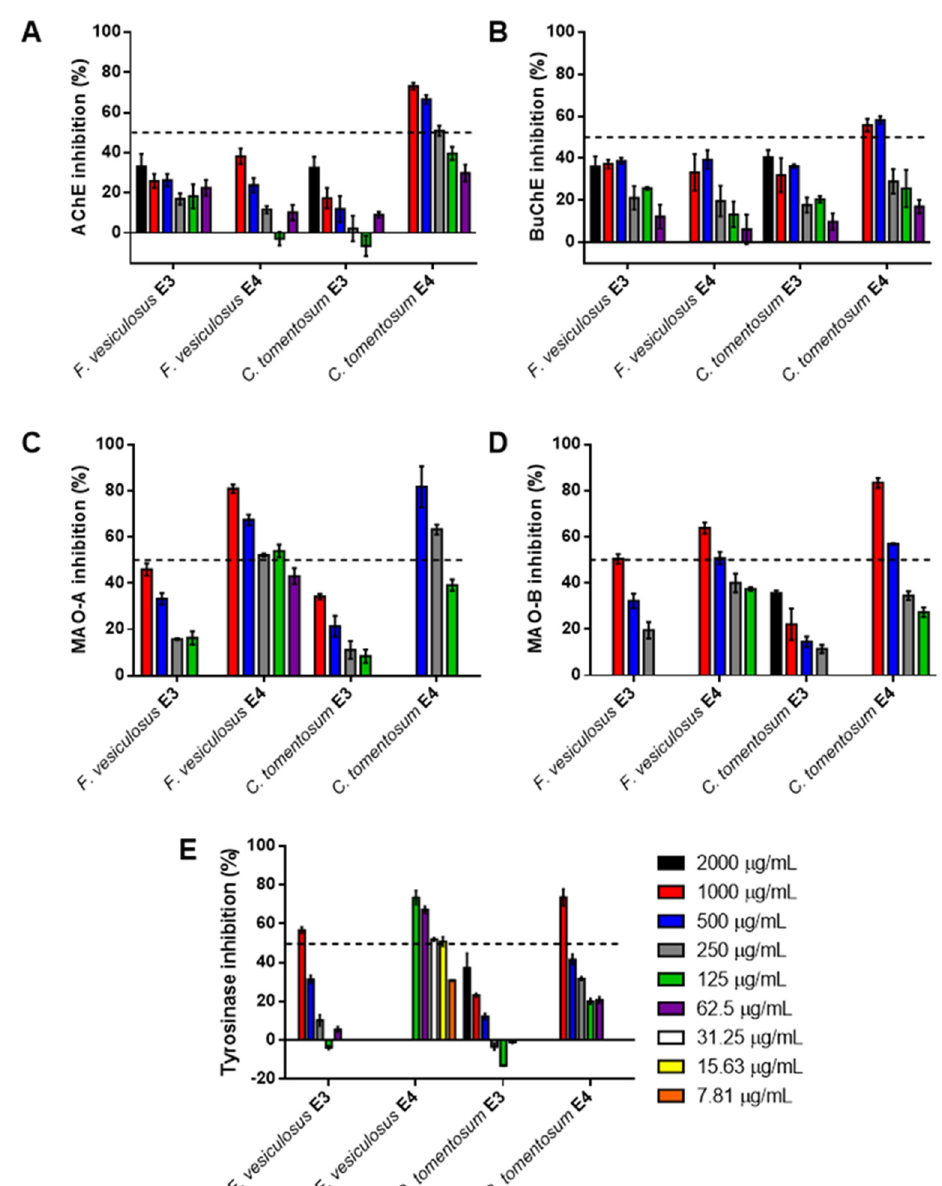
Figure 2. Enzyme inhibition activity of F. vesiculosus and C. tomentosum E3 and E4 fractions: ( A ) AChE inhibition, ( B ) BuChE inhibition, ( C ) MAO-A inhibition, ( D ) MAO-B inhibition, ( E ) Tyrosinase inhibition. Results are expressed as mean ± SEM of three assays performed each one in tripli- cate.